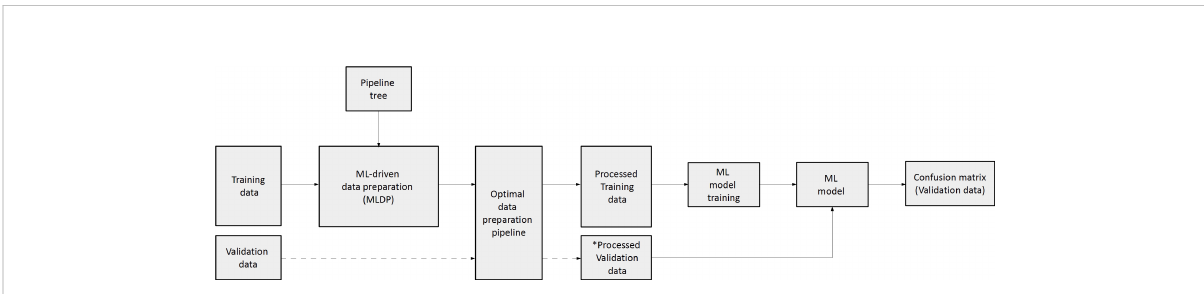
FIGURE 3 The concept of machine learning-driven data preparation (MLDP). Given a training and validation subset pair, the training subset is the input of MLDP, which has access to the pipeline tree (Figure 2). The MLDP identi fi es an optimal data preparation pipeline from the tree by solely analyzing the training subset. The preprocessed training dataset is the input for machine learning (ML) to build the prediction model. Data preparation algorithms that operate in the feature space are also applied to the validation subset (e.g., feature selection). The preprocessed validation subsets serve as inputs to the built ML prediction model to estimate cross-validation performance of the given model. ML – Machine learning; * - only preparation steps, which operate in feature space (feature selection/dimensionality reduction) are applied on validation data.